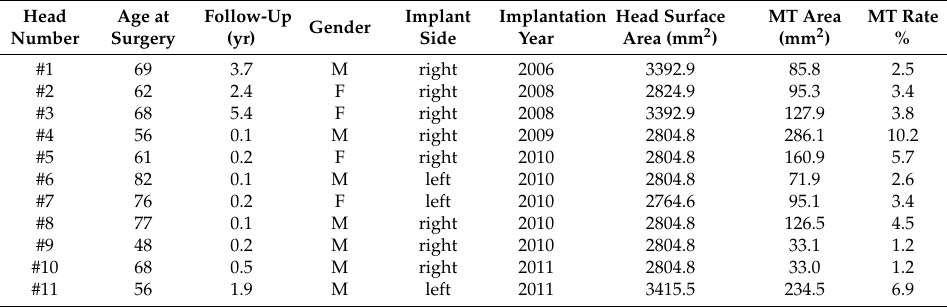
Table 1. Details on the Biolox ® delta retrievals under study (head surface area, MT area, and MT rate % data from [31]).